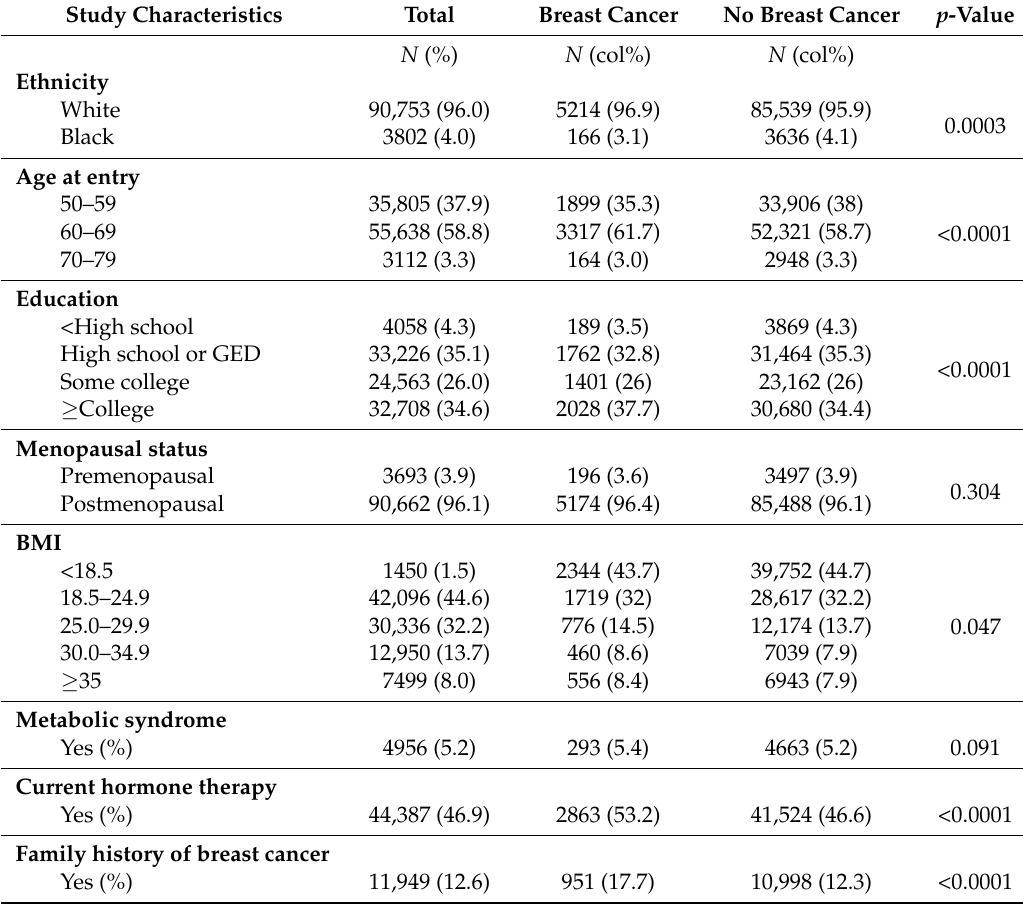
Table 1. Baseline characteristics of the participants by breast cancer incidence during follow-up. Study